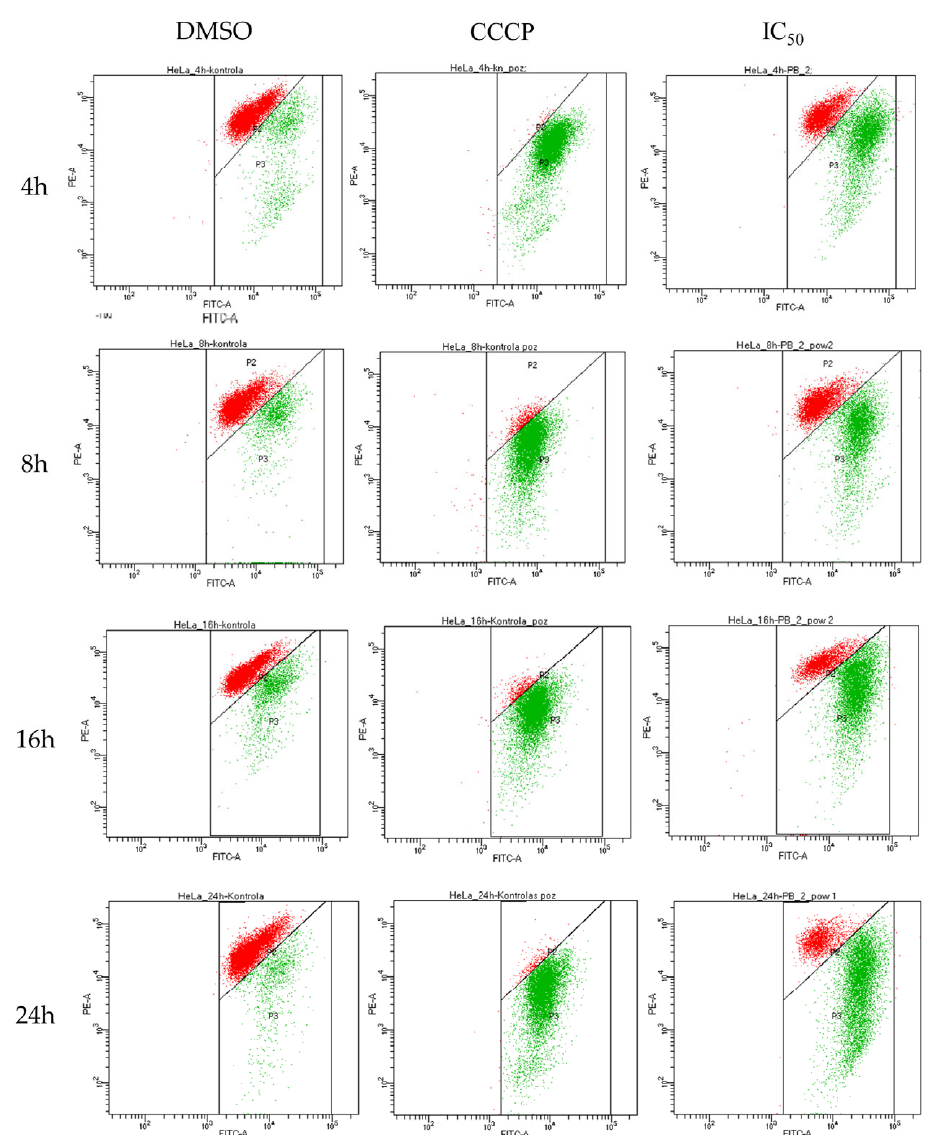
Figure 13. Rinderol induced alterations in mitochondrial membrane potential expressed as a percent of HeLa cell population with depolarized mitochondrial membrane. Data are the means ± SD of at least three independent replicates. Asterisk (*) indicates statistically significant differences ( p ≤ 0.05) between consecutive rinderol concentrations within the same incubation period (DMSO–0.4%, 1/2 more selective anticancer therapeutics. Furthermore, it was lately reported that angularly IC 50 –2.83 μ g/mL, IC 50 –5.66 μ g/mL, 2 × IC 50 –11.32 μ g/mL). Grids (#) indicate results which were annellated isomers of furanonaphthoquinone napabucasin, the first-in-class cancer stem- significantly different ( p ≤ 0.05) in comparison to the previous time point of the same rinderol ness inhibitor, demonstrate significantly higher anticancer potency [44]. Considering that concentration. rinderol also possess such preferential structure, further research would be highly justified.